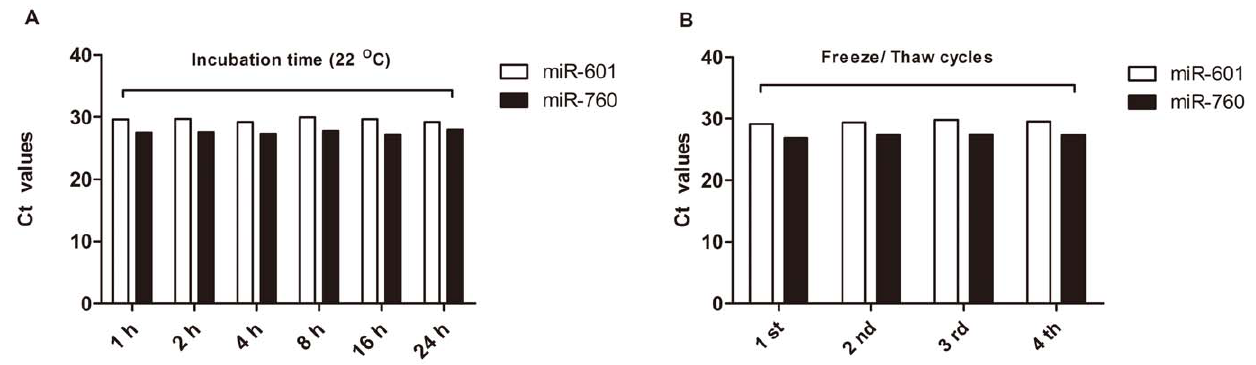
Figure 5. Plasma miR-601 and miR-760 stability experiment. Plasma levels of miR-601 and miR-760 were stable after prolonged room temperature incubation from 1 to 24 hours(A) or at least 4 freeze-thaw